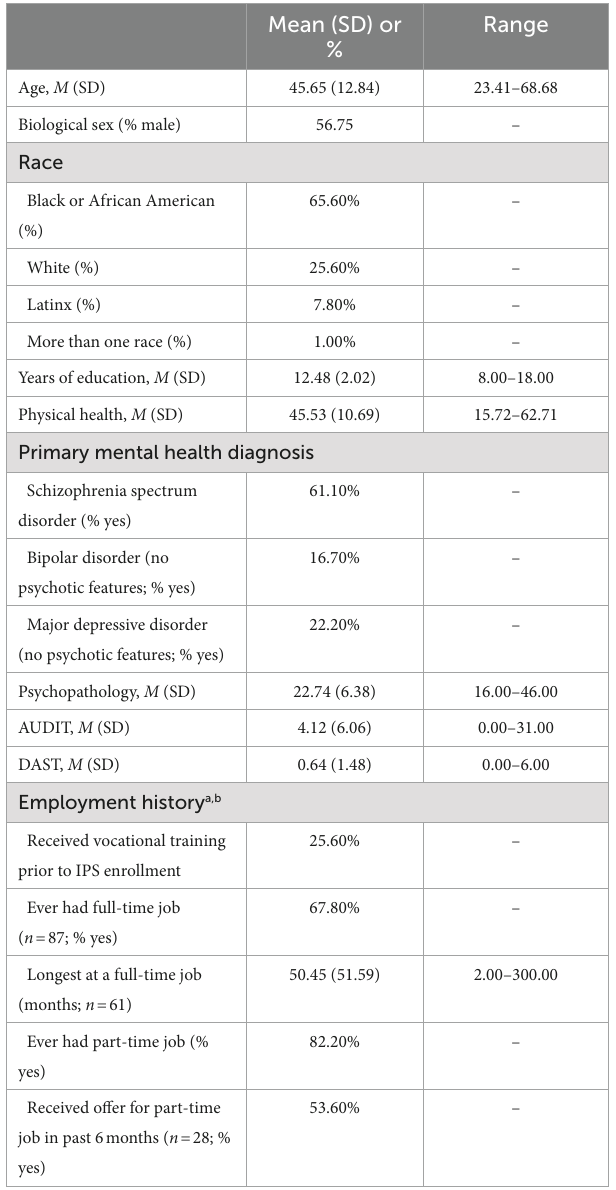
TABLE 1 Participant background, clinical, and work history characteristics ( n =